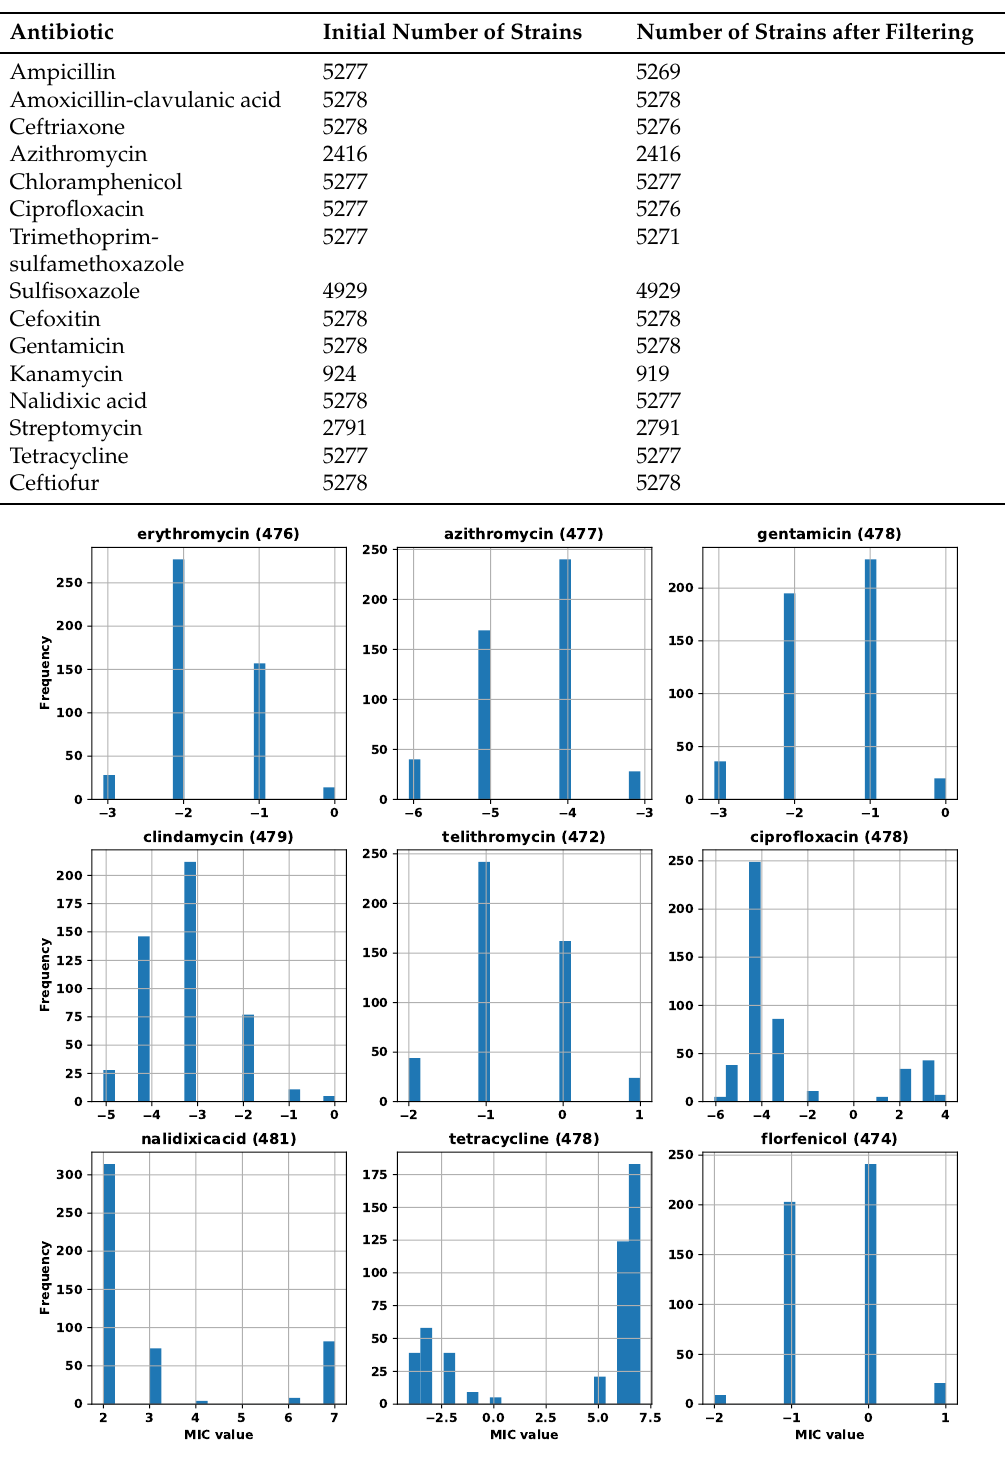
Figure A1. Distribution of C. jejuni MIC values for different antibiotics. These are the values after processing and conversion to log 2 scale. The antibiotic’s name is printed on the title of each sub-figure. The number of genomes is presented in